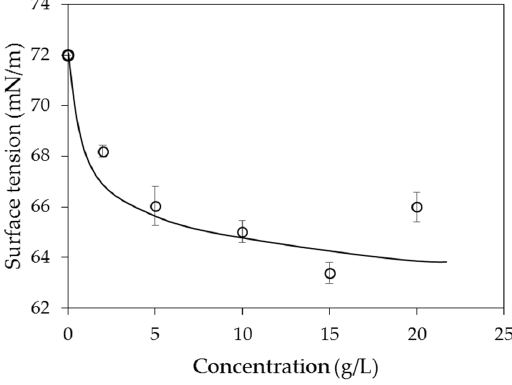
Figure 7. Surface tension of PAM solutions in air.